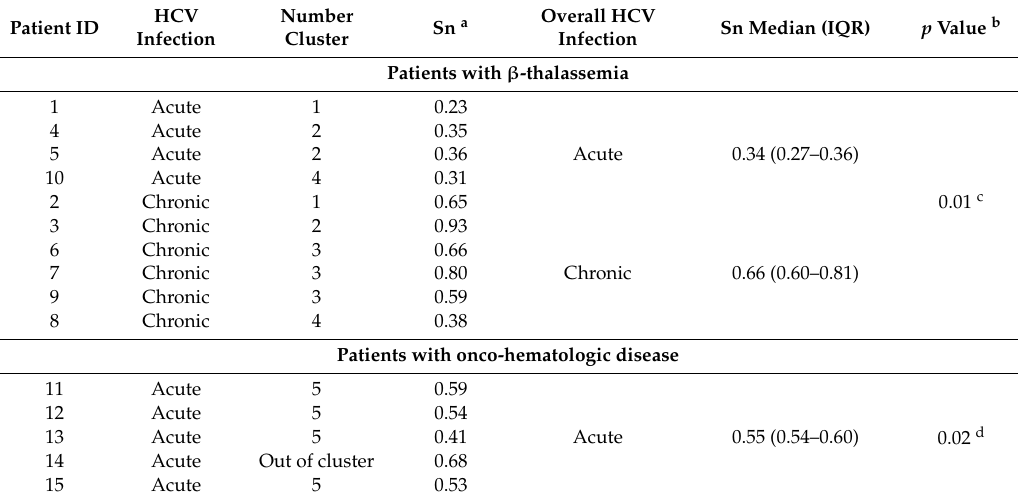
Table 4. Amino Acid Variability was estimated for each NS5A amino acid position for each